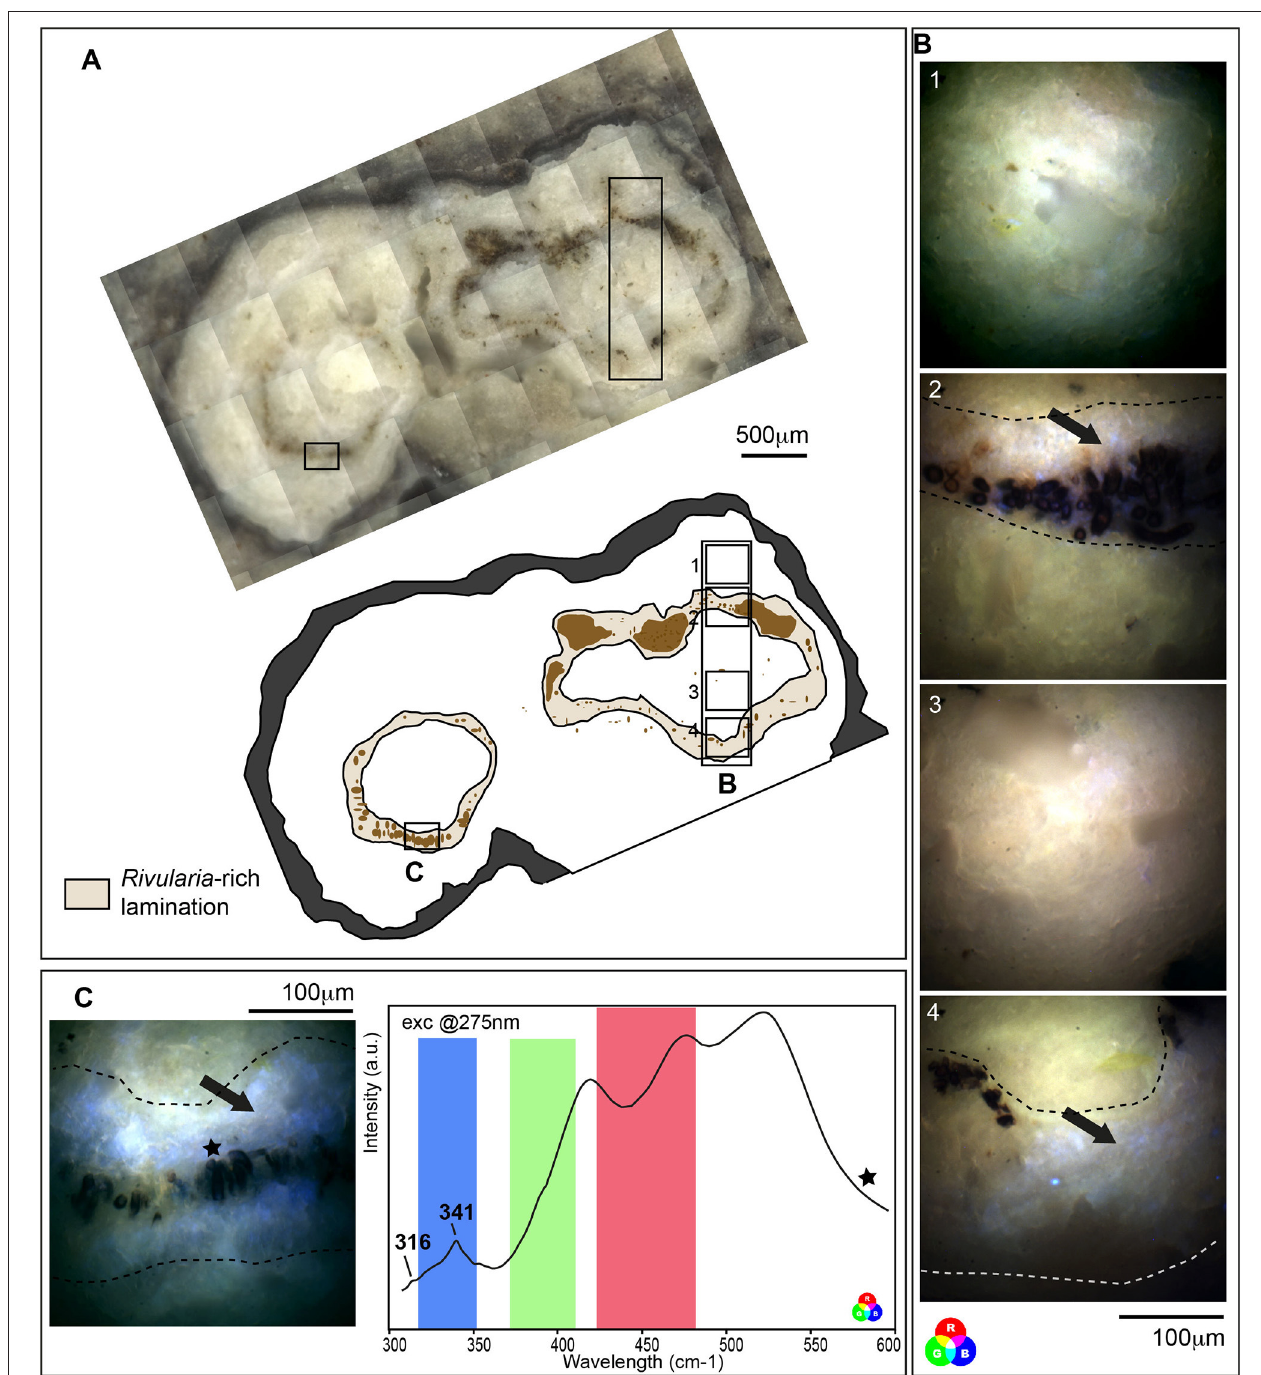
FIGURE 9 | Fluorescence emission signal after synchrotron-based deep UV excitation at 275nm of a cross section of an oncoid associated with a black pustular mat. (A) Optical microscopy observation and schematic representation of the cross section highlighting Rivularia -rich laminations with encrusted Rivularia -like cells. The localization of areas of interest analyzed by S-DUV fluorescence imaging is given. (B) Composite RGB images of 4 areas of interest were reconstructed using the fluorescence signal collected with filters between 327 and 353nm (Blue), 370 and 410nm (Green) and 420 and 480nm (Red). They were surimposed on the optical image. An intense fluorescence signal was observed using the blue filter between 327 and 353nm (black arrows) in Rivularia -rich laminations (underlined by dot lines in B,C ) while the rest of the matrix is marked by a mixed fluorescence collected using the green and red filters. (C) The fluorescence emission signal associated with Rivularia -rich laminations was recorded and showed two bands at 316 and 341 cm − 1 . The fluorescence ranges covered by the three filters are indicated with respective colors and the precise localization where the spectrum was collected is given by a black star on the associated full-field RGB fluorescence image.